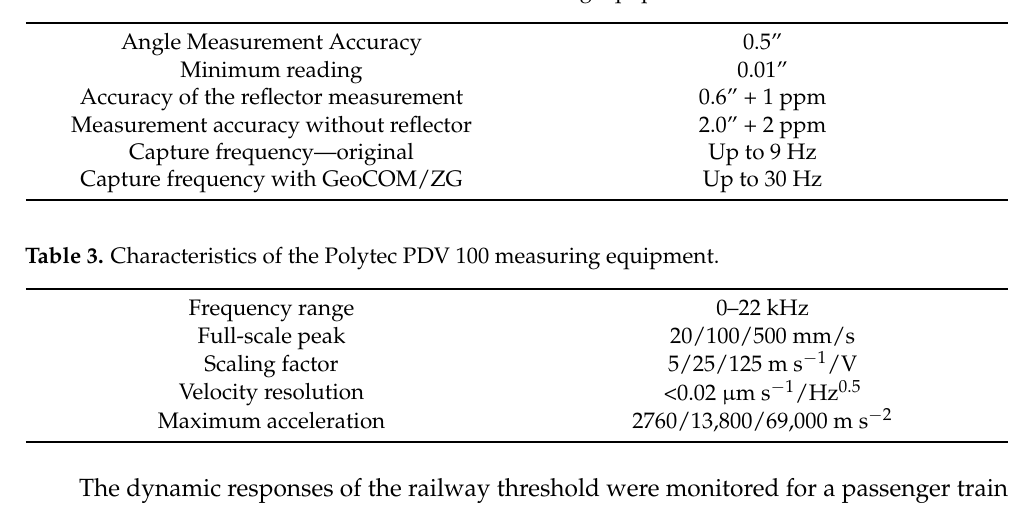
Table 2. Characteristics of the RTS Leica TS 50 measuring equipment. Table 1. Characteristics of the Instantel Minimate Plus measuring equipment .